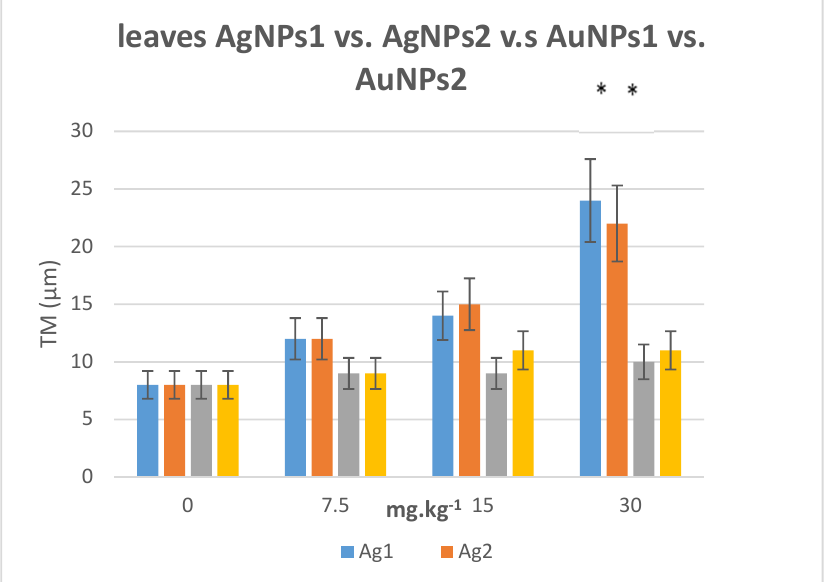
Figure 5. The average median tail moments in leaf nuclei of N. tabacum plants cultivated for 8 weeks in soil polluted with aqueous solutions of AgNPs and AuNPs (size AgNPs1 12–15 nm and AgNPs2 22–25 nm, AuNPs1 12–15 nm and AuNPs2 22–25 nm). The plants were cultivated at 22–28 °C in a plant growth room with a 16 h photoperiod. The error bars represent the standard error of the mean. (*) Significantly ( p < 0.05) different values comparing to the control.